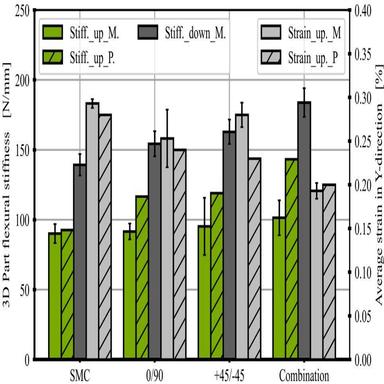
Flexural stiffness and average strain in the Y-direction in ROI 3 for 3D parts under the ball-on-cylinder test ("Stiff.", "M" and "P" mean stiffness, experimental measurements, and numerical prediction, respectively. "up." and "down." indicate parts characterised by the cylinder contacting the side wall (upwards) and tray bottom (downwards), respectively).